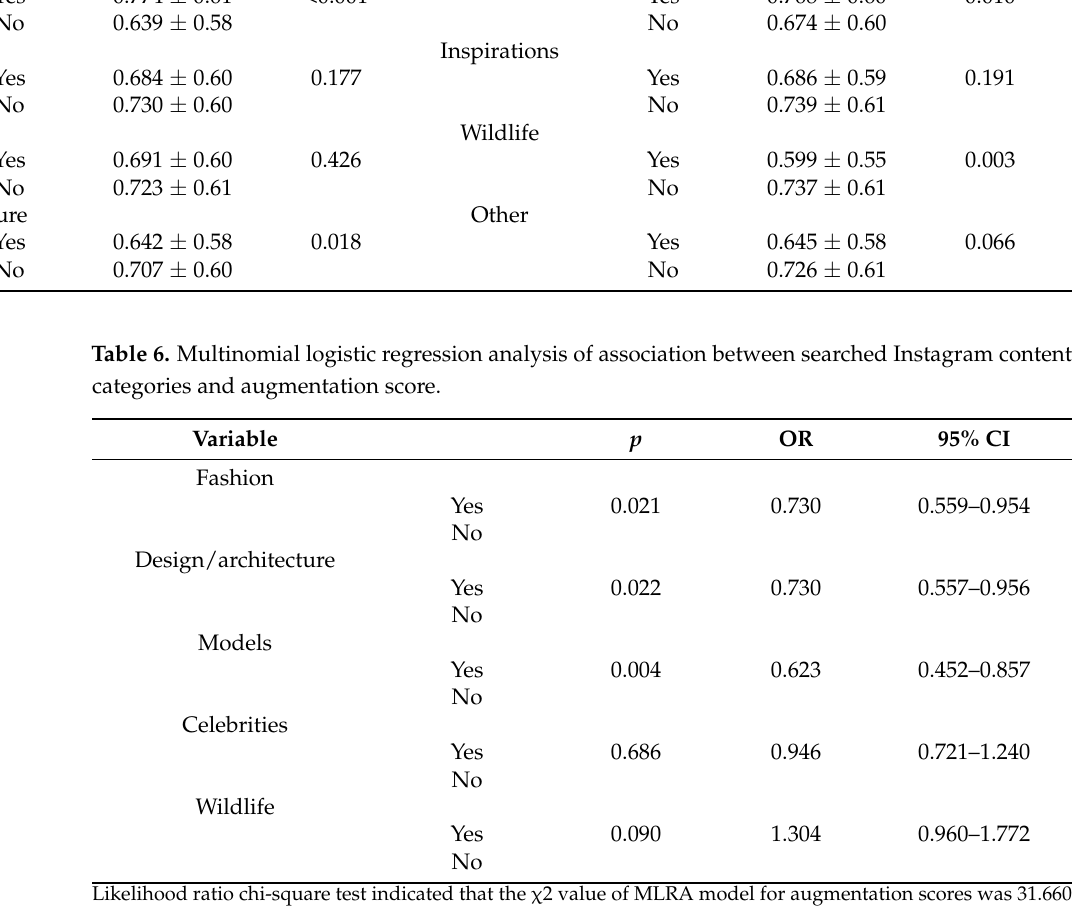
Table 5. Univariate analysis of associations between augmentation scores and Instagram content categories ( n = 1050). Variable